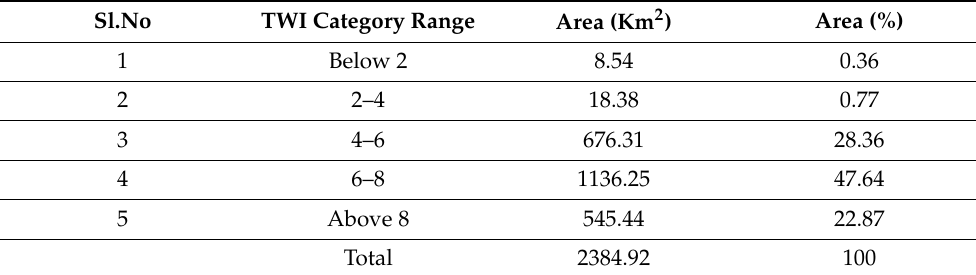
Figure 10. Mean NDWI for maize growing season Rabi (October to January 2021). Table 2. The mean TWI category in the